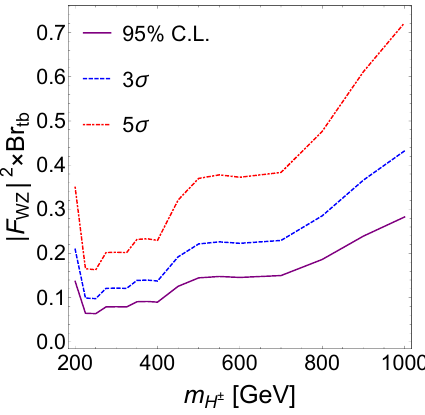
Figure 3 . Sensitivities to j F WZ j 2 (cid:2) B tb in pp ! jjH (cid:6) ; H (cid:6) ! tb with the integrated luminosity of 3 ab (cid:0) 1